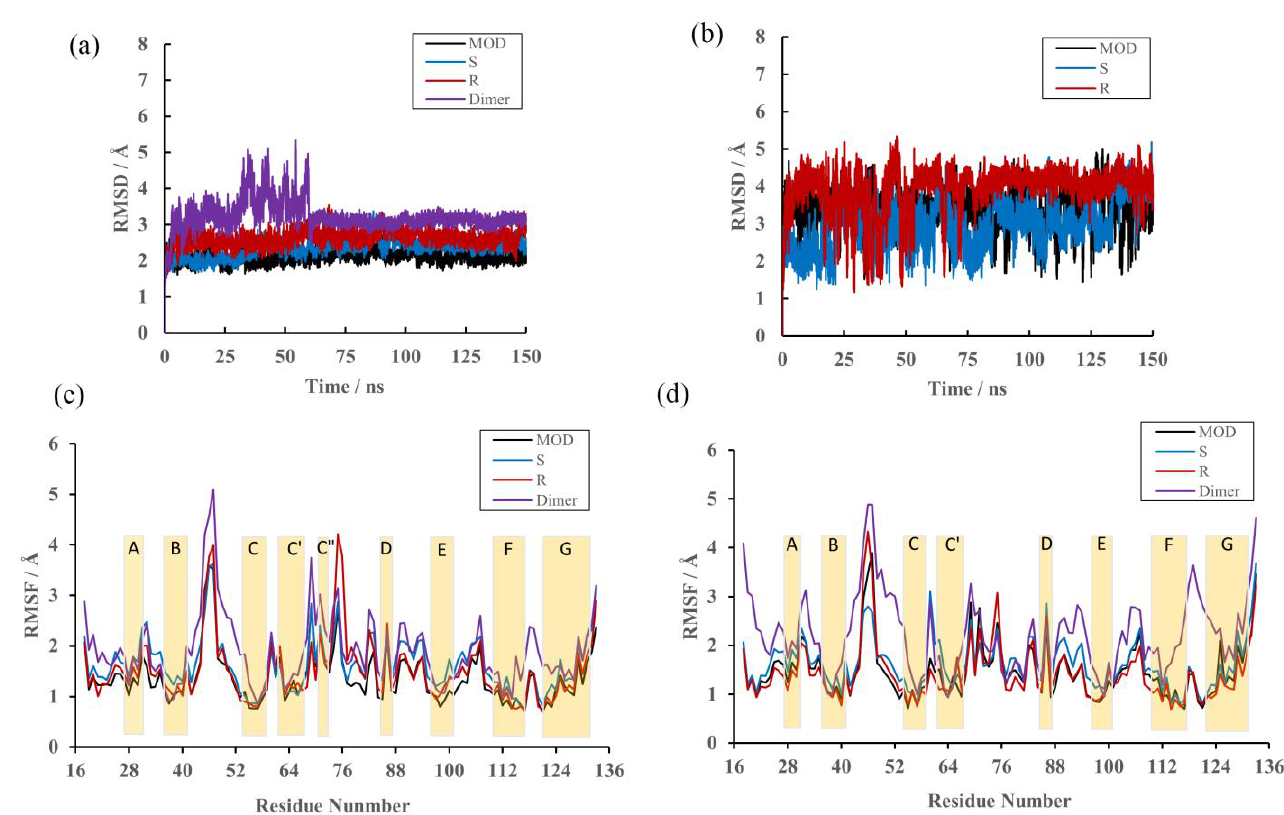
Figure 2. RMSD and RMSF results of the MD simulations. ( a ) RMSDs of backbone atoms in the MOD, S, R and dimer systems. ( b ) RMSDs of heavy atoms in (MOD)-BMS-200, (S)-BMS-200 and (R)-BMS-200. ( c ) RMSF fluctuations of residues on A PD-L1. ( d ) RMSF fluctuations of residues on B PD-L1.